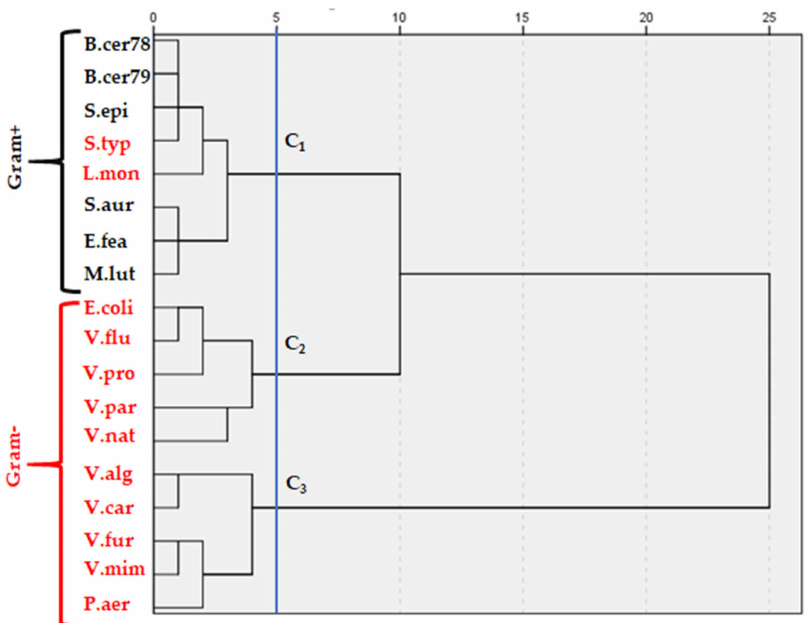
Figure 1. Hierarchical cluster analysis (HCA) of bacterial strains, according to their responses to all EOs, based on MIC and MBC values. Clustering was established according to ward